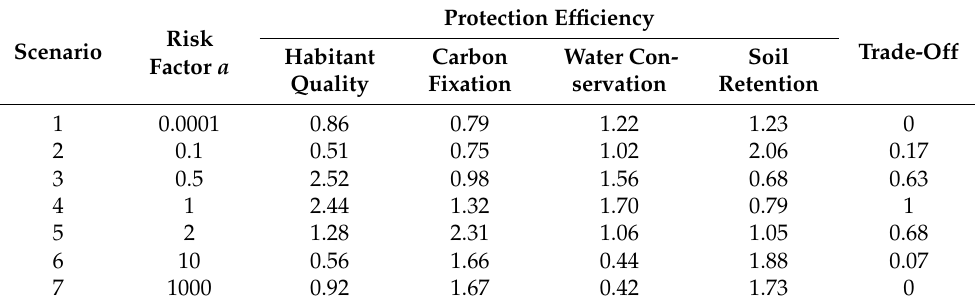
Table 3. Protection efficiency and trade-off of priority conservation areas for ecosystem services.